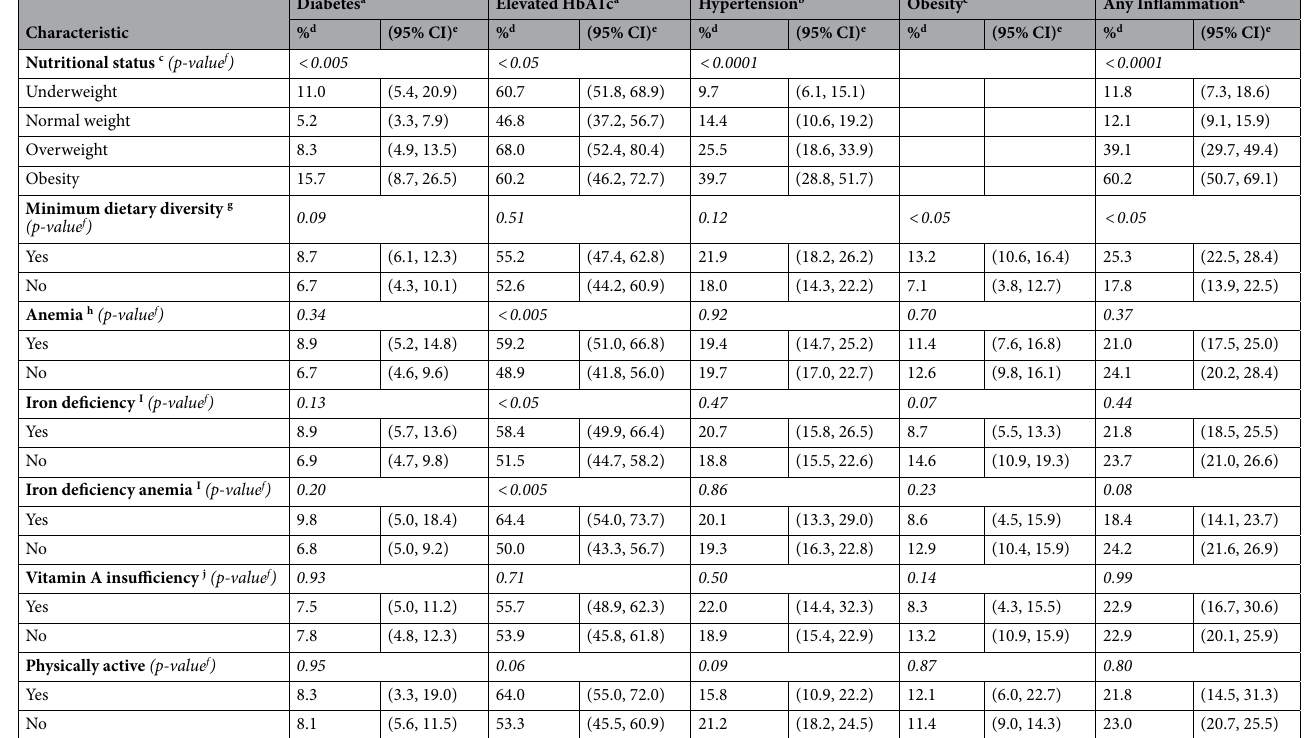
Table 2. Associations between cardio metabolic risk factors and nutrition and health indicators in non- pregnant women, The Gambia, 2018. a Diabetes defined as glycated hemoglobin (HbA1c) ≥ 6.5% and elevated HbA1c as ≥ 5.7% b Hypertension defined as systolic blood pressure of ≥ 140 mmHg and/or a diastolic blood pressure of ≥ 90 mmHg. c Underweight, overweight, and obesity defined as body mass index (BMI) of < 18.5 kg/ m2, ≥ 25- < 30 kg/ m2 and ≥ 30 kg/ m2, respectively. d Percentages weighted for non-response and survey design. e CI = confidence interval, adjusted for cluster and stratified sampling design. f Chi-square p-value < 0.05 indicates that the proportion in at least one subgroup is statistically significantly. g Minimum dietary diversity was met if the number of food groups consumed the day prior to the interview was ≥ 5 (25). h Anemia defined as hemoglobin < 120 mg/L. I Iron deficiency defined as serum ferritin < 15 µg/l; iron deficiency anemia defined as low serum ferritin and low hemoglobin. j Vitamin A insufficiency defined as retinol